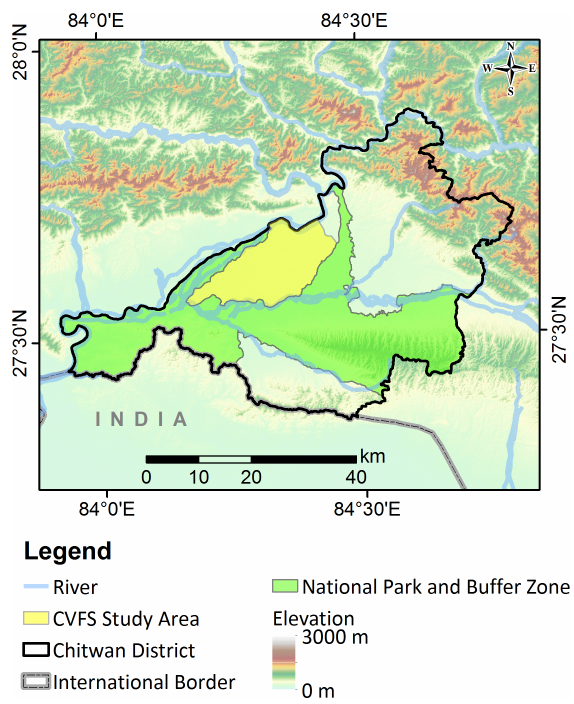
Fig. 1 . Overview map of the Chitwan District. CVFS = Chitwan Valley Family